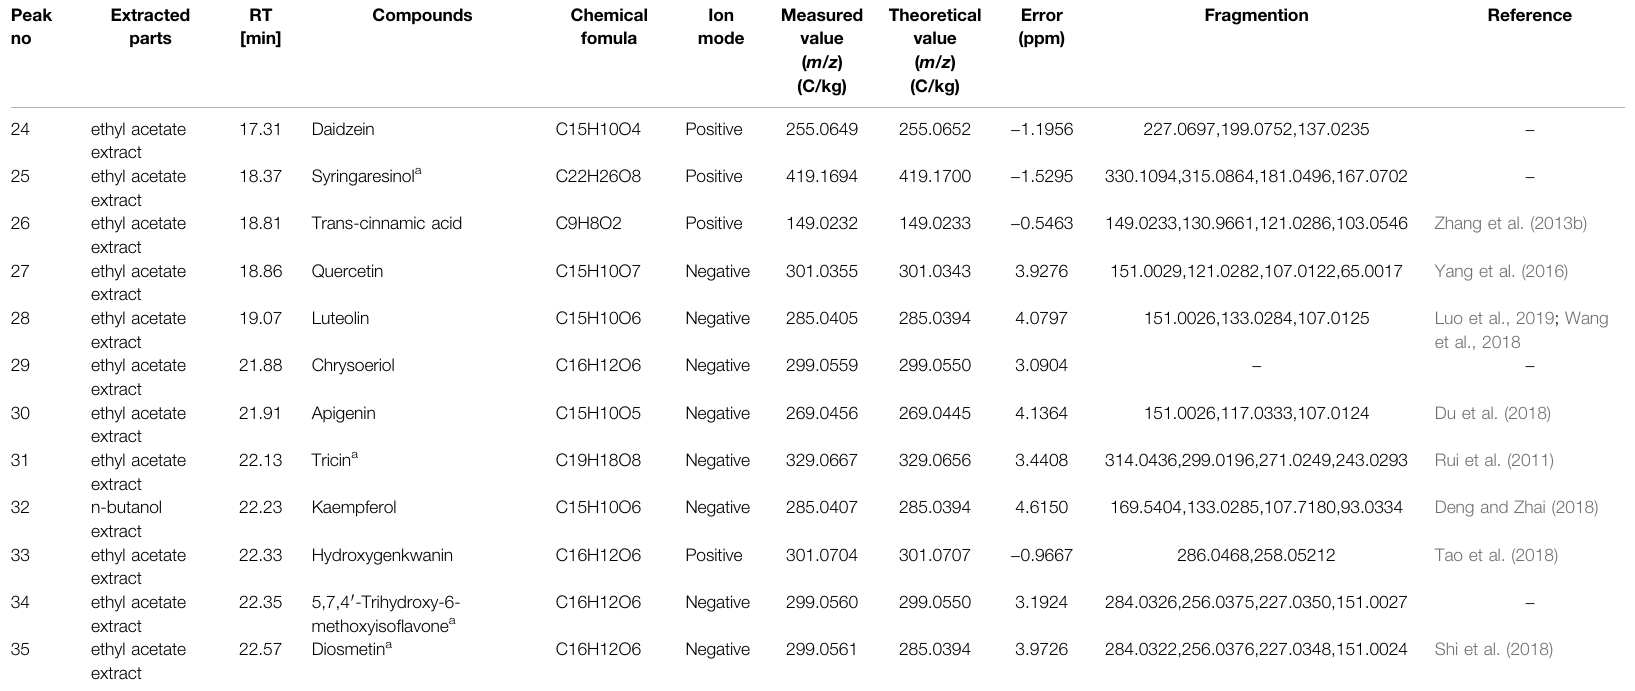
a Compared with standard